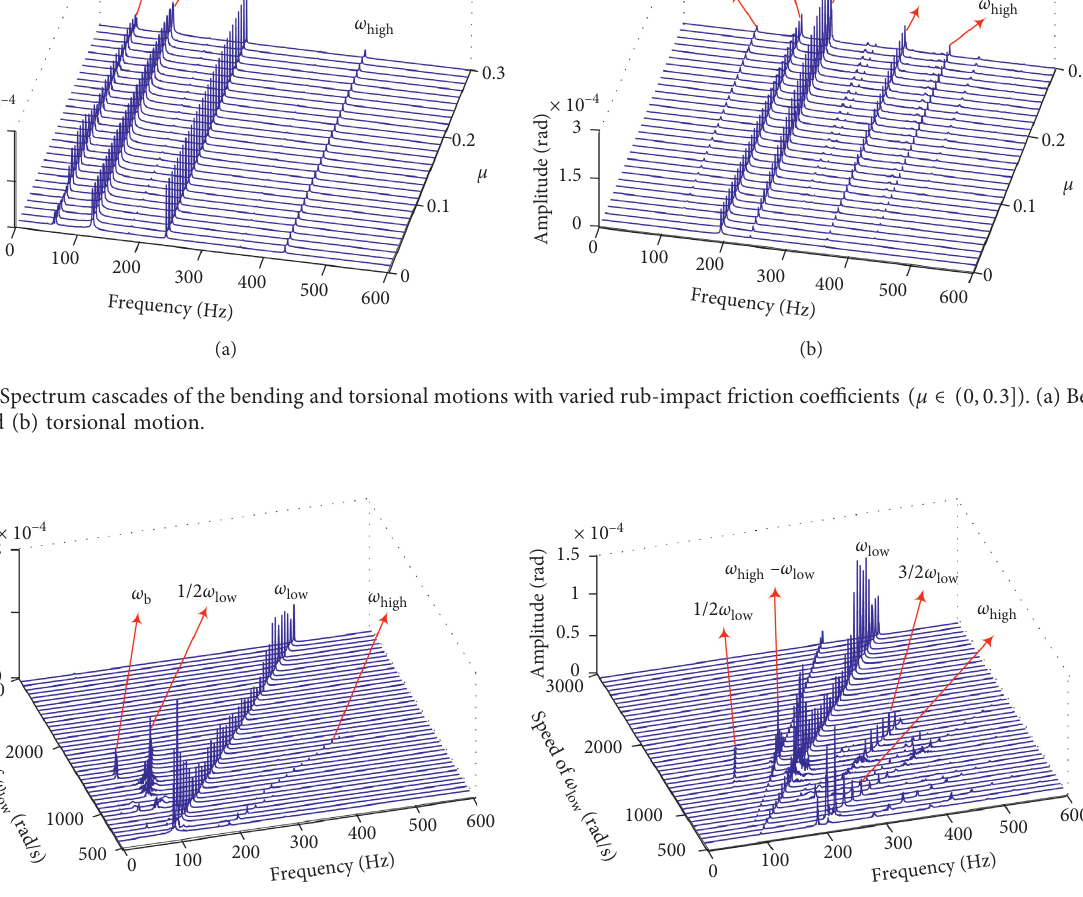
∈ ( 500 ( rad/s ) , 3000 ( rad/s )]) . low